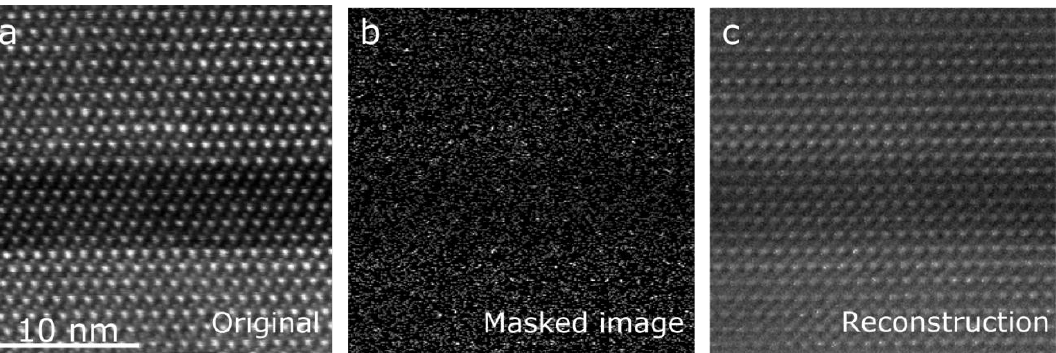
Figure 3. Experimental realization of compressed sensing for STEM imaging. ( a ) Conventional high resolution STEM image; ( b ) image over the same region of the same sample, where 20% of the pixels are acquired and 80% are blocked; and ( c ) the reconstructed image.